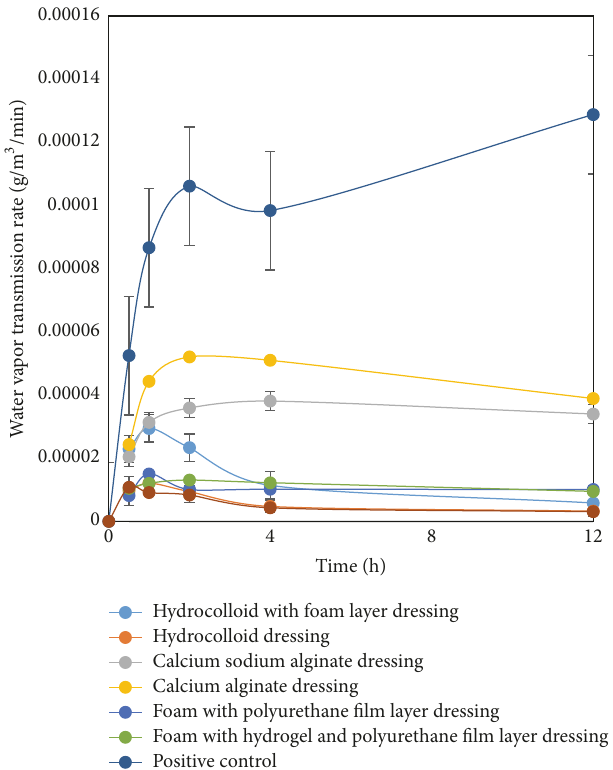
Figure 4: Water vapour transmission